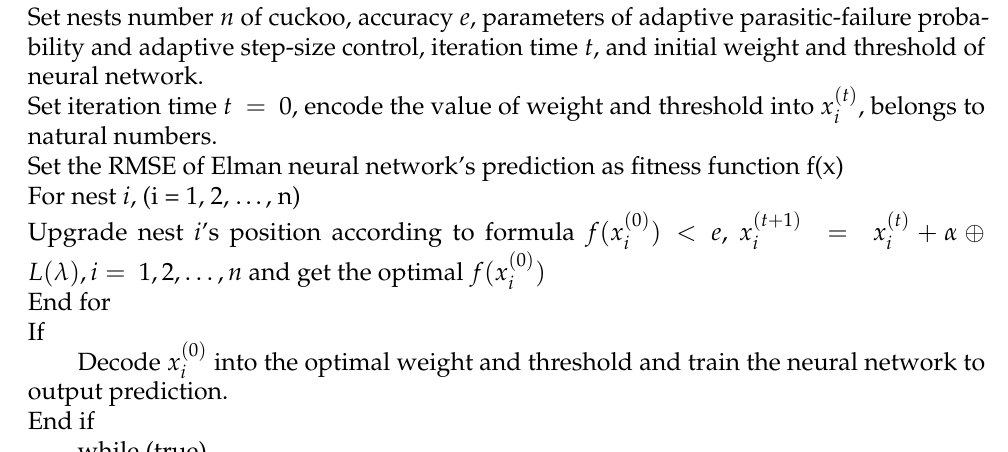
Algorithm 1 The pseudocode of the TMCS-ENN prediction